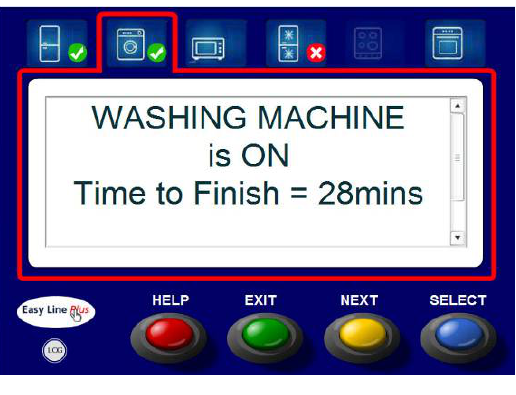
Figure 6. User interface screen showing information about the washing machine